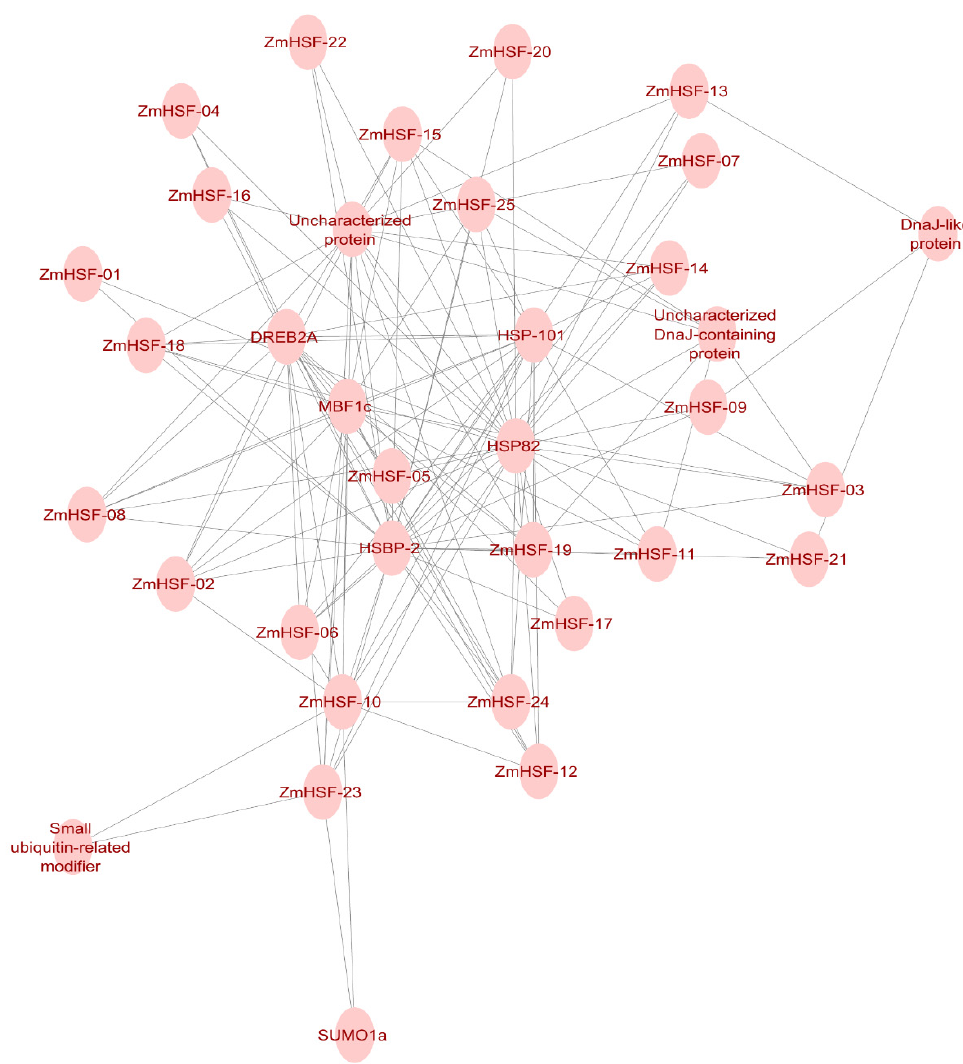
Figure 12. Protein–protein network of maize HSFs. The line connecting two proteins represents that an interaction exists between them.